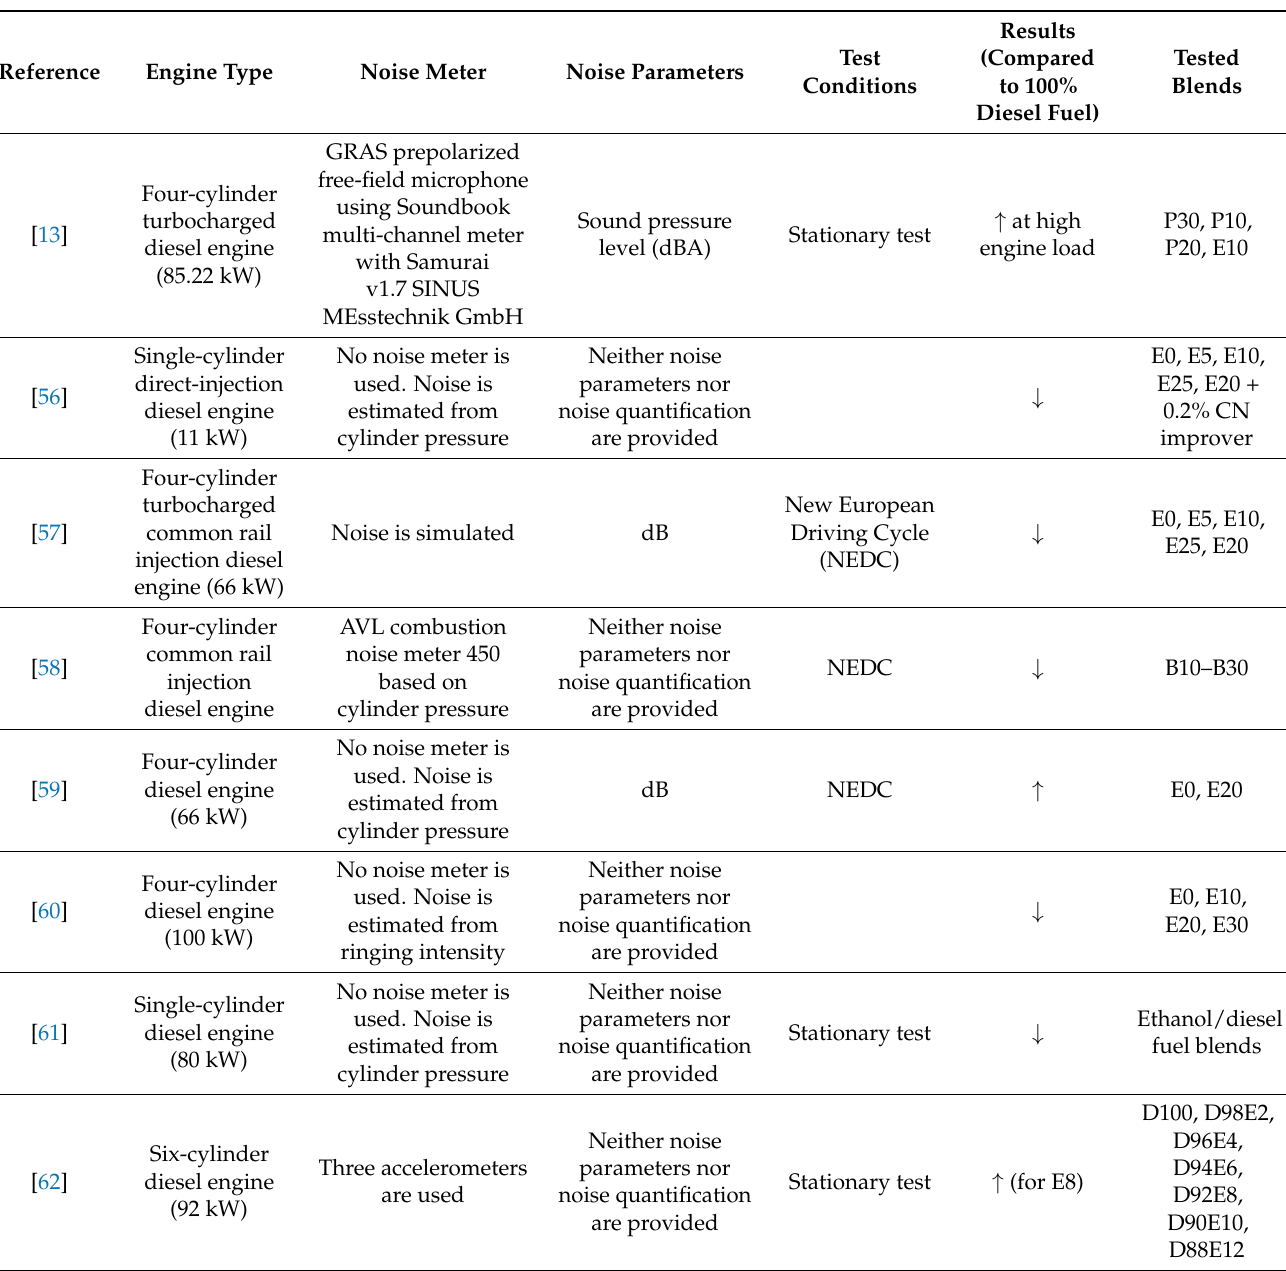
Table 2. Literature revision about diesel engine noise emissions resulting from the usage of alcohol/diesel fuel blends.